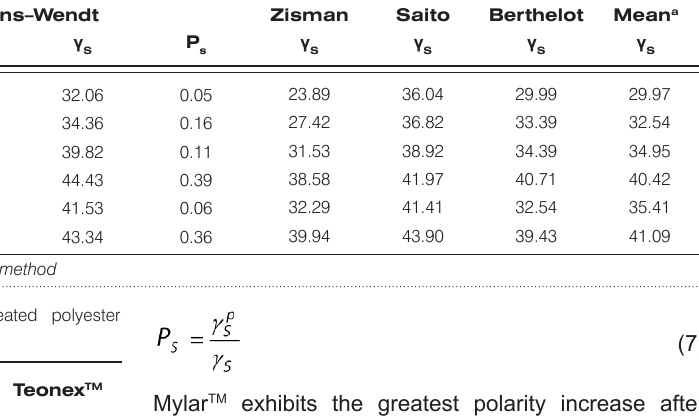
Table 5. SFE and polarity of polyester substrates, unmodified and treated for 30 minutes with NaOH solution. [mJ m -2 ]